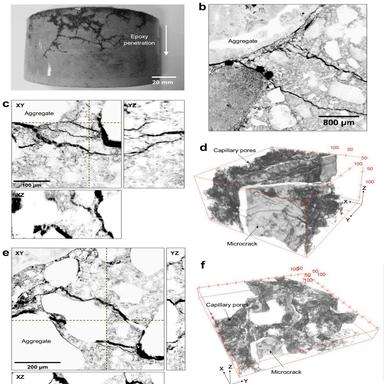
LSCM imaging results of C-FT concrete. a, Microcracks on the cylinder surface revealed by epoxy impregnation. b, 2D overview of the microcracks acquired with a 5× objective. c–f, Orthogonal views (c, e) and 3D renderings (d, f) of the reconstructed single-FOV (c–d) and extended (e) image volumes acquired with a 40× objective. All dimensions in μm.